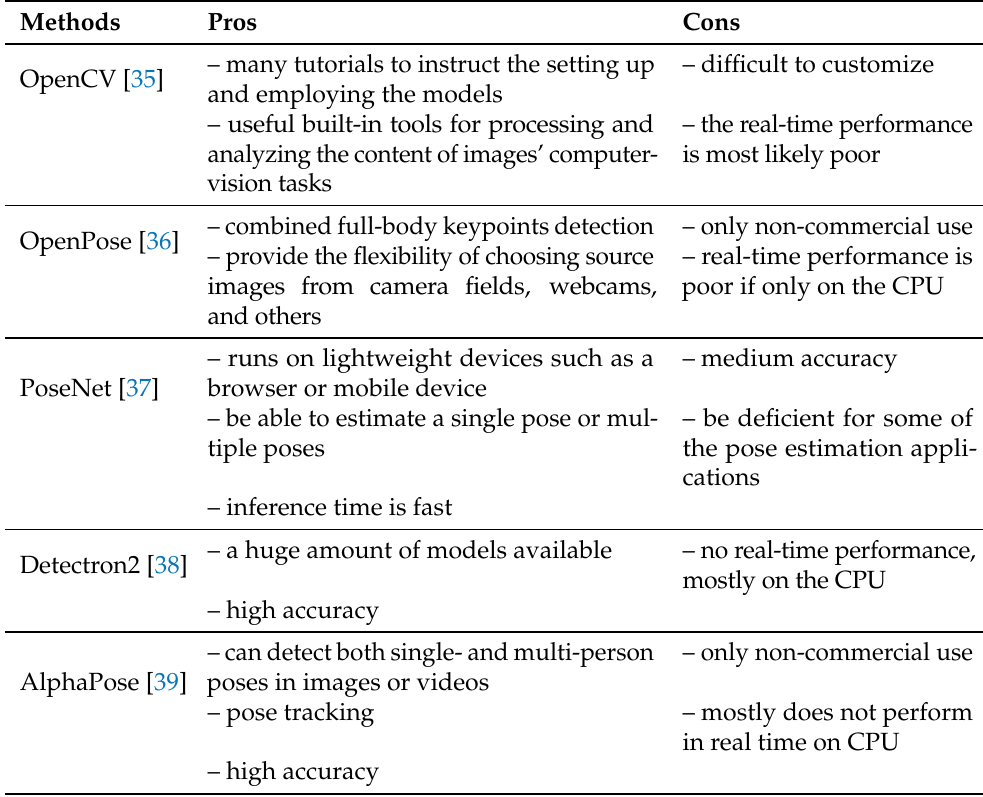
Table 2. The Pros and cons of five kinds of human-pose-estimation (HPE) libraries and models.